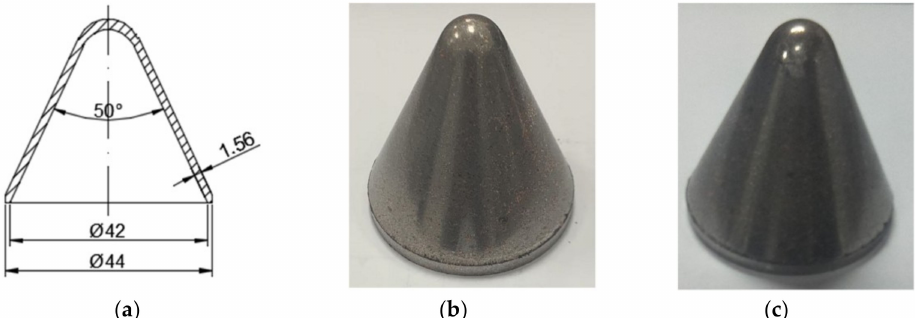
Figure 2. Sketch and photographs of PTFE / W / Cu / Pb liners at di ff erent preparation stages: ( a ) sketch; ( b ) pressed samples; ( c ) sintered